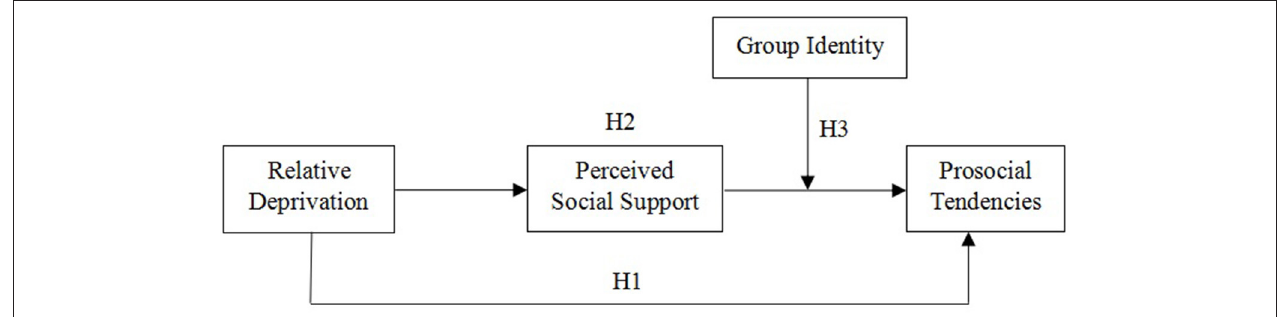
FIGURE 1 | Moderated mediation model of the current